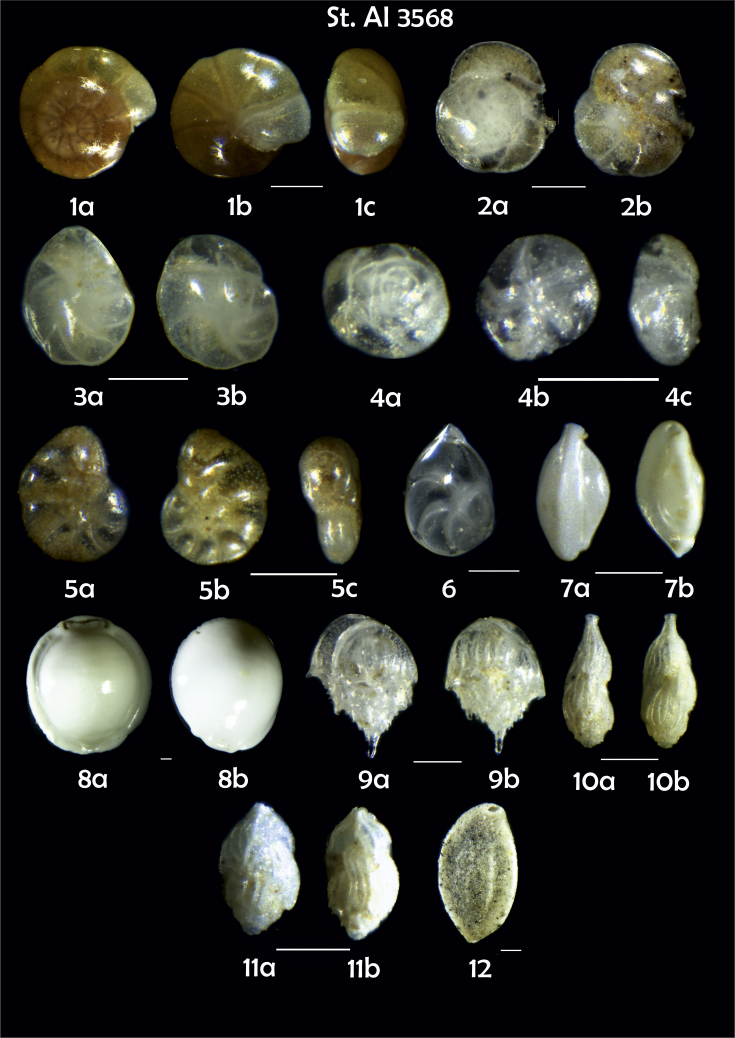
Station 35681Gyroidina orbicularis, a spiral view, b umbilical view, c lateral view.2Gavelinopsis praegeri, a spiral view, b umbilical view. 3Cassidulina teretis, a lateral view, b apertural view. 4Alabaminella weddellensis, a spiral view, b umbilical view, c lateral view. 5 ? a, umbilical, b spiral view, c apertural view. 6Lenticulina gibba. 7Triloculina trihedraa, b lateral view. 8Pyrgo murrhina, a, b lateral view. 9Bulimina mexicana, a, b lateral view. 10Trifarina angulosa, a, b side view. 11Trifarina? sp., a, b side view. 12Sigmoilopsis schlumbergeri. Scale 100 μm.